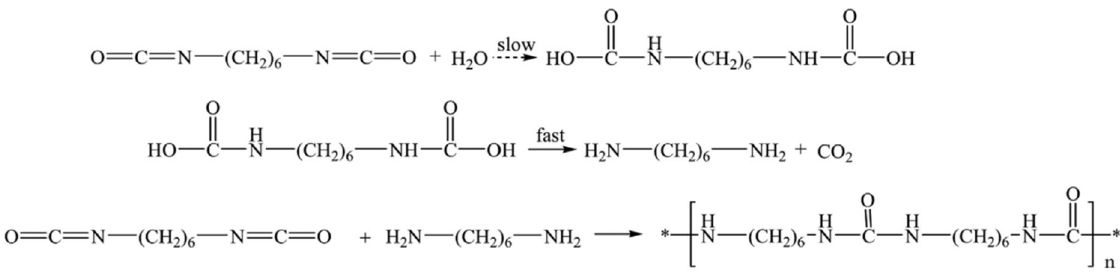
Scheme 5. Representation of synthesis of polyurea based on HDI and